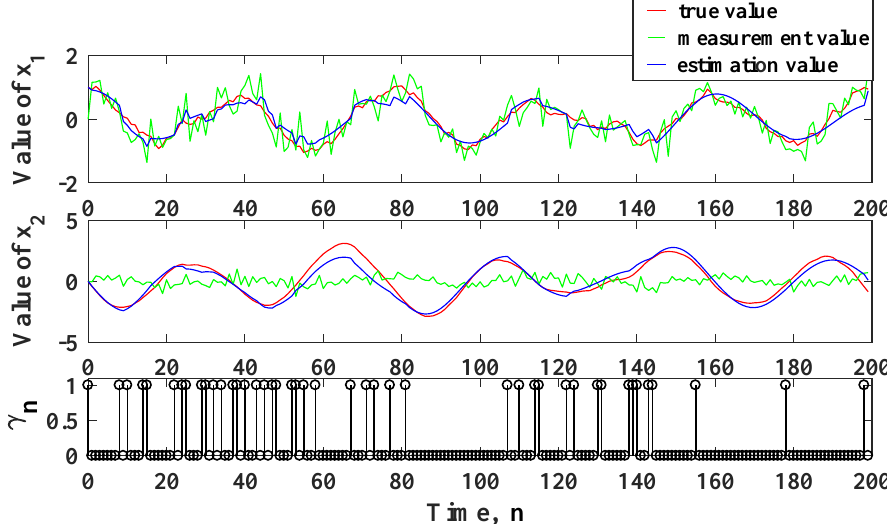
Figure 2. The actual state, estimation and event trigger time.